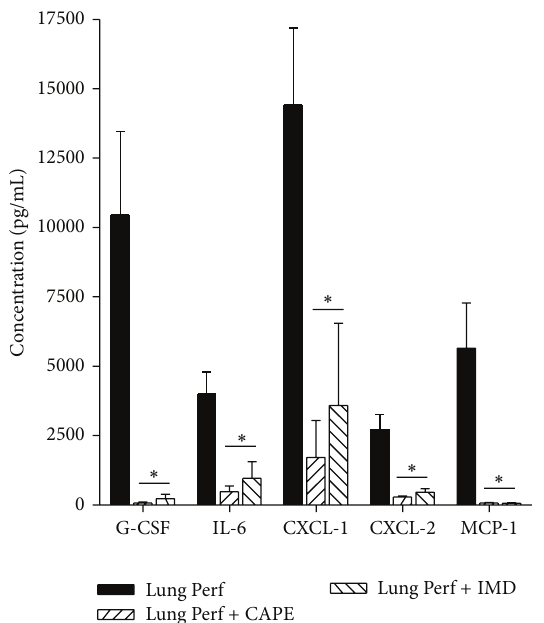
Figure 3: NF- 𝜅 B inhibitor effect on cytokine concentrations in MLEC-exposed media. G-CSF, IL-6, CXCL-1, CXCL-2, and MCP- 1 after 8 h exposure to lung perfusate and treatment with CAPE or IMD. ∗ 𝑃 < 0.05 versus lung perfusate, ± SEM.